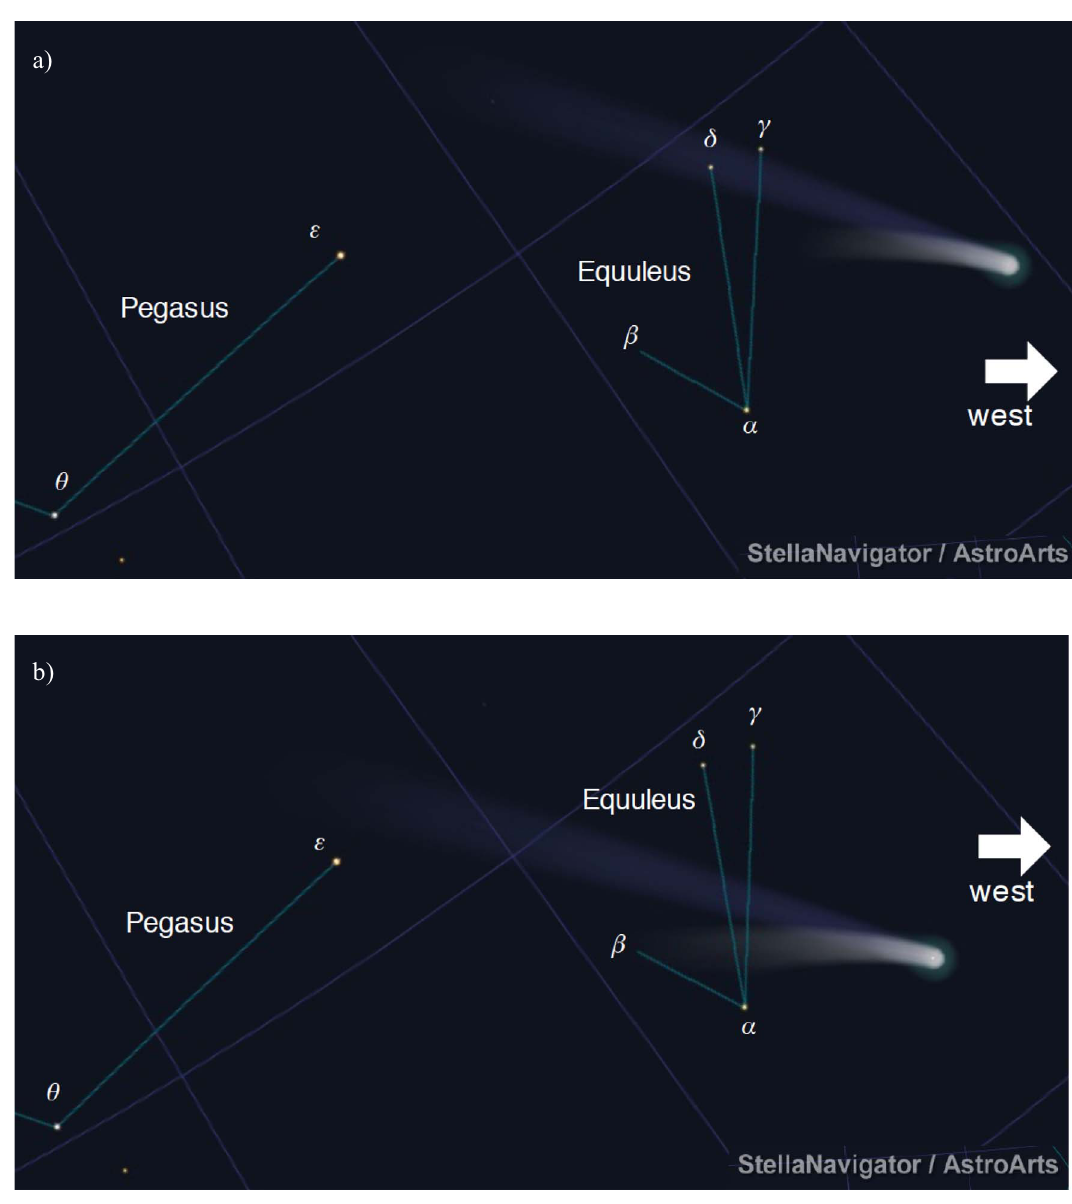
Fig. 4. Computed cometary tails at Leuven on 1577 November 28 with (a, above) the existing perihelion argument ( x = 255.673 (cid:3) ) (Woldstedt 1844; Marsden and Williams, 2008); and (b, below) the modi fi ed perihelion argument ( x = 253.0 (cid:3) ) using Stellar Navigator